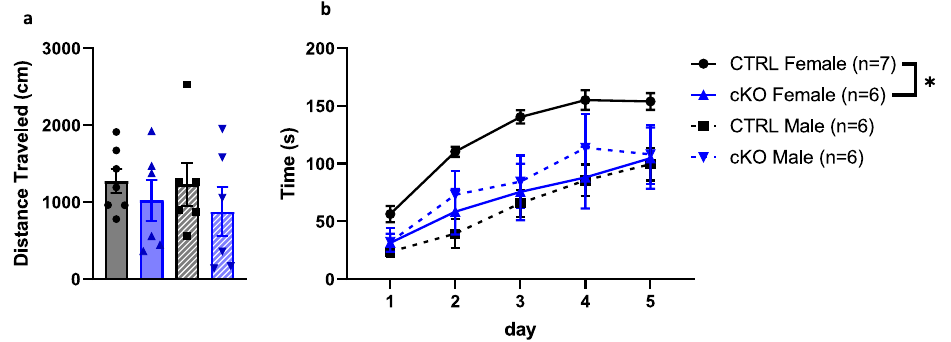
Figure 1. Loss of neuronal Ca V 1.2 causes impaired motor performance learning in female but not male mice. ( a ) No differences in locomotor activity were detected in distance traveled in the open field test between neuronal Ca V 1.2 cKO mice and CTRL littermates. ( b ) Female neuronal Ca V 1.2 cKO mice display a shorter latency to fall than CTRL littermates on the accelerating rotarod. No differences in rotarod performance were detected between CTRL and cKO males. Data are expressed as mean ± s.e.m, using EthoVision 14, www. noldus. com/ ethov ision-